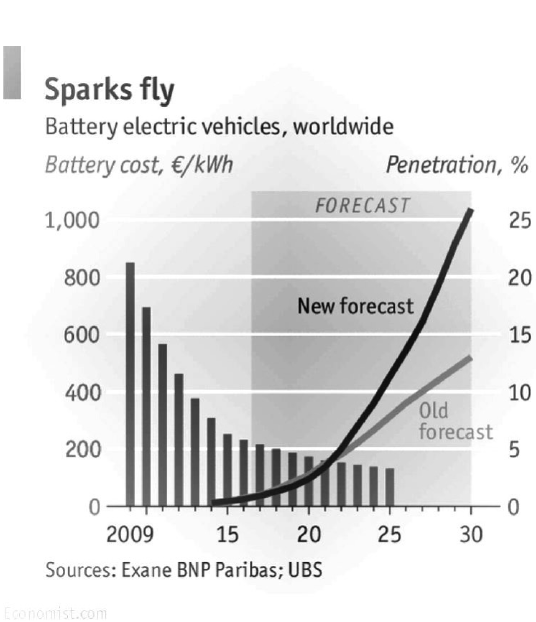
Fig. 5. – Expected battery cost and market penetration of electric vehicles to